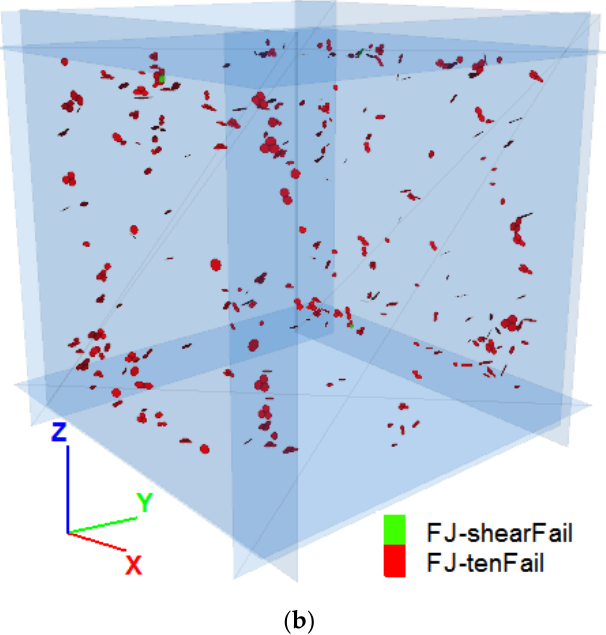
Figure 9. Cracks formed in the sample at point E when the sample follows stress path ( a ) OEC, σ 1 = 90 MPa, σ 2 = 0 and ( b ) ODEC, σ 1 = σ 2 = 90 MPa. ( a ) 533 tensile and 3 shear, ( b ) 470 tensile and 5 shear.